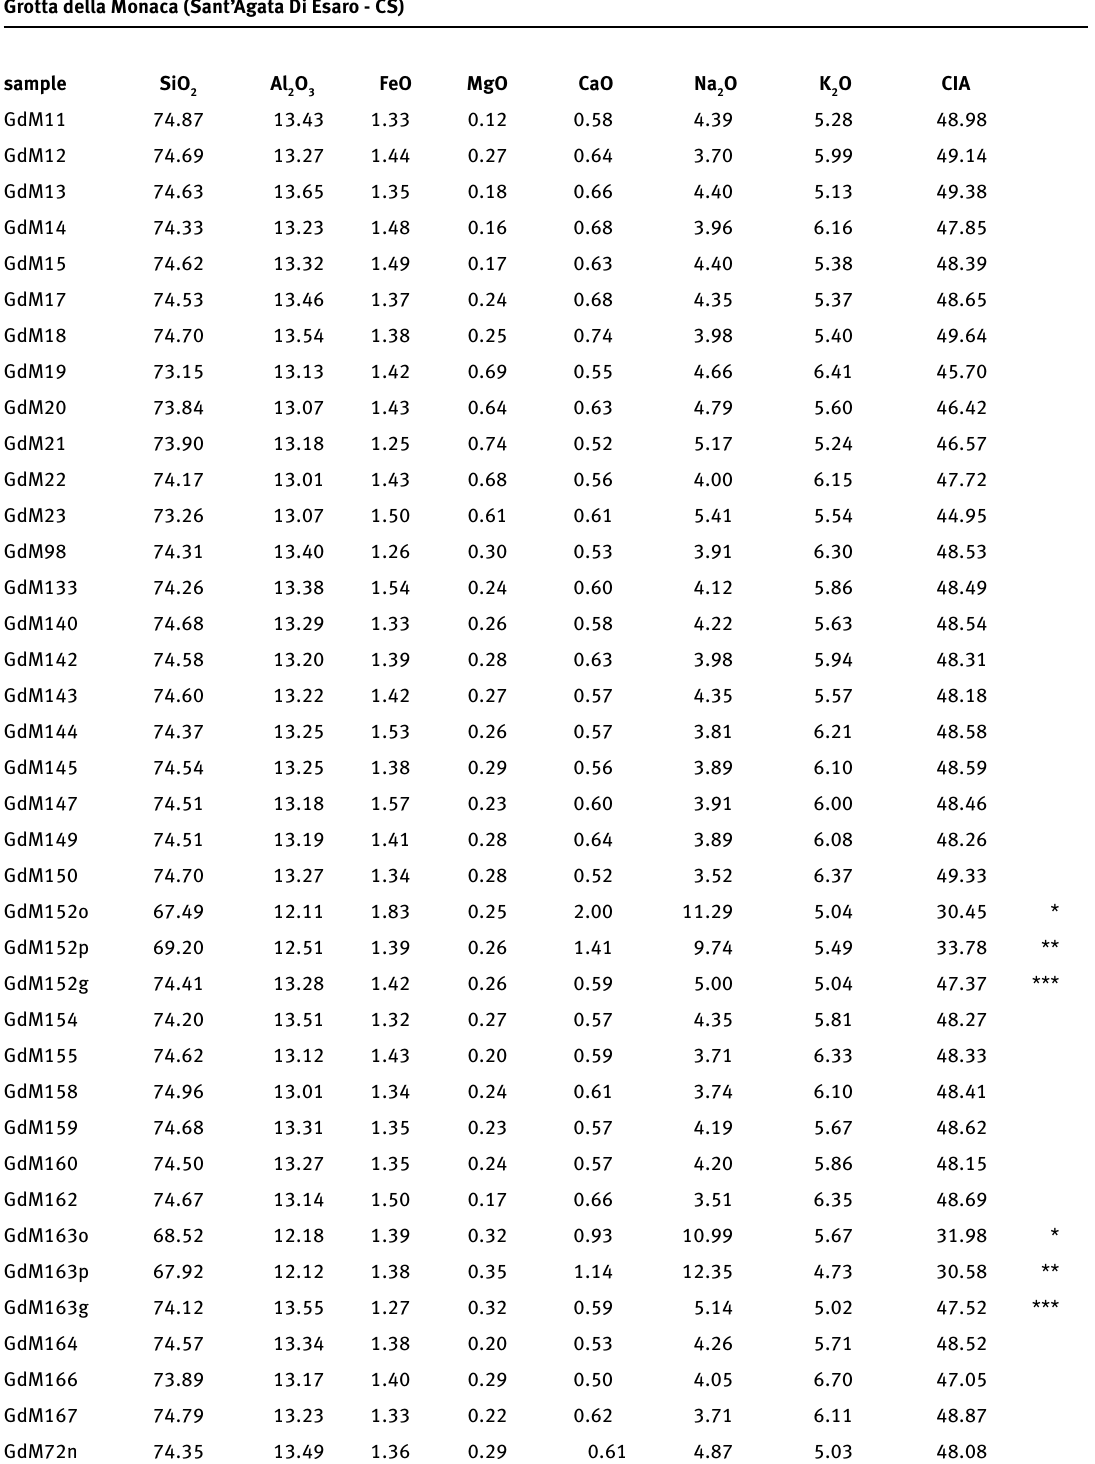
O /(Al O + CaO + Na O + K O) in mol.%]. 2 3 2 3 2 2